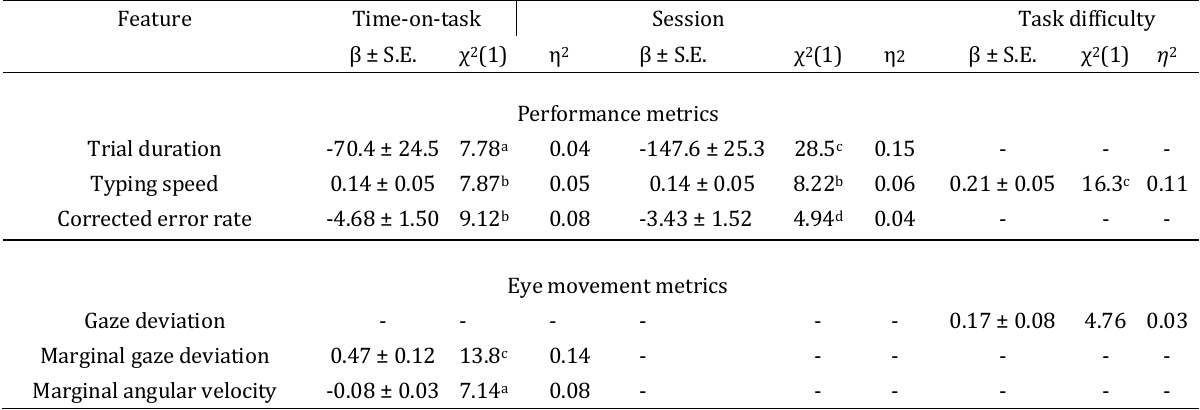
Table 2: Linear mixed effects model results of the metrics adjusted for alertness indicating the main effects of time-on-task, session and task